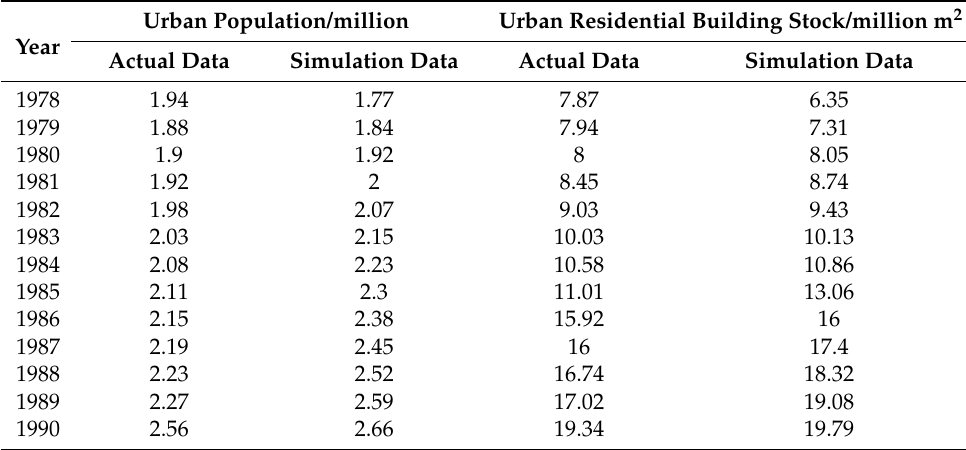
Table 4. Comparison between the simulated data and actual